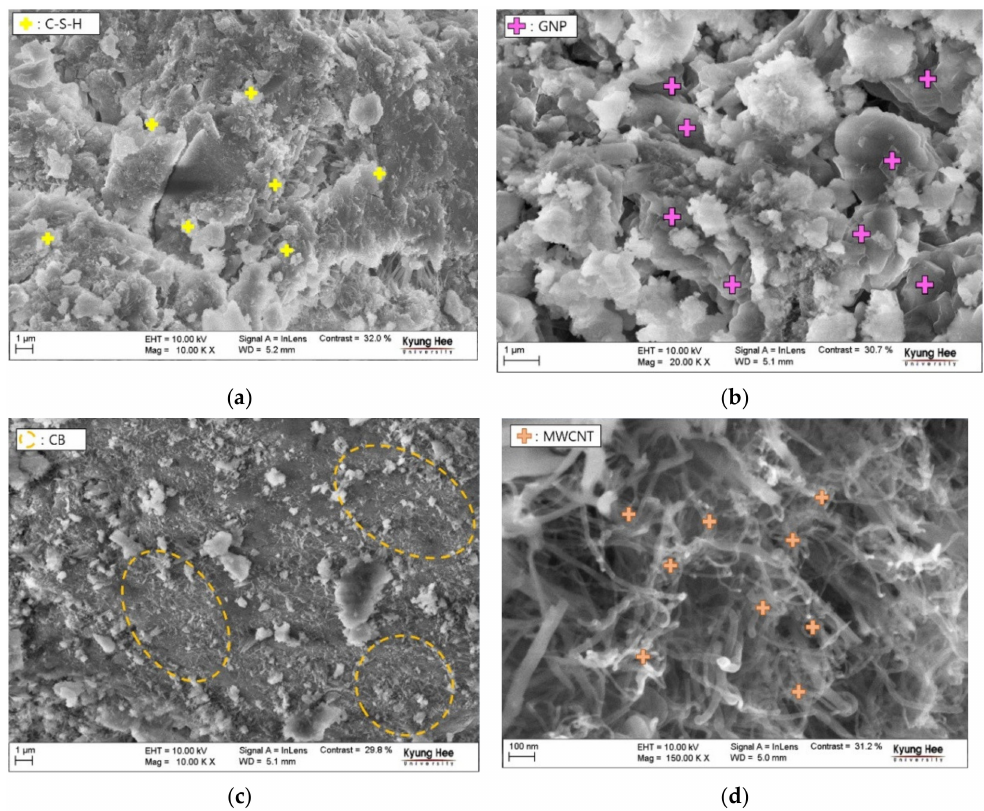
Figure 10. Field-emission scanning electron microscopy images: ( a ) OPC; ( b ) GNP-1.0; ( c ) CB-1.0; ( d )